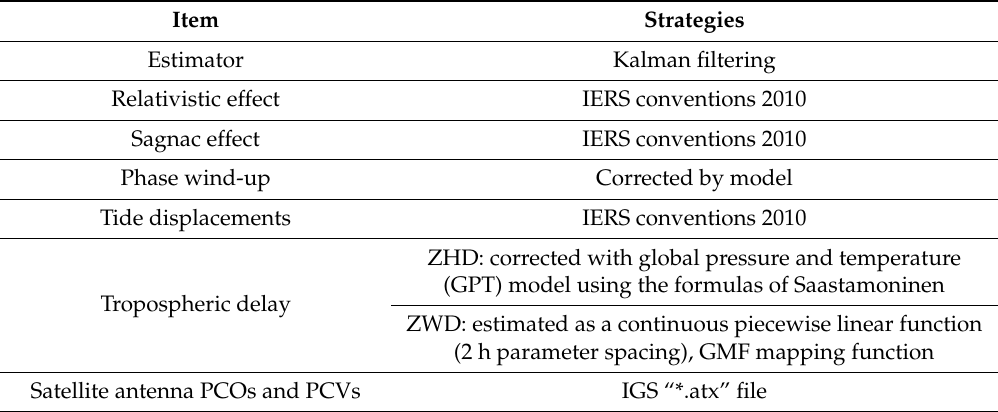
Table 1. Summary of GPS PPP (global positioning system precise point positioning) processing